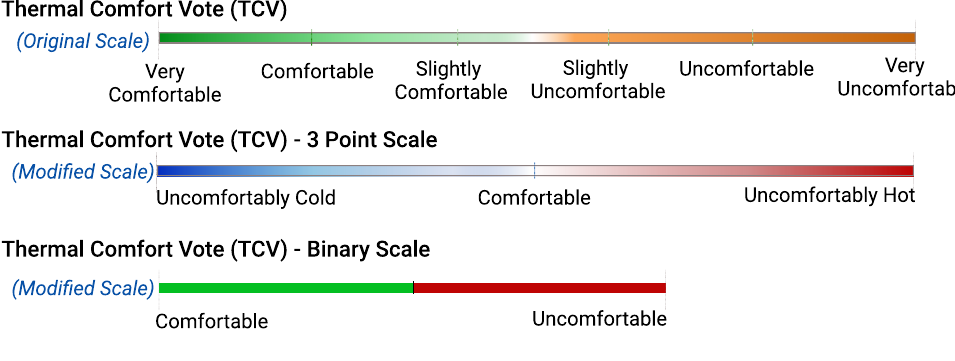
Figure 14. Example of reclassification of TCV metric.